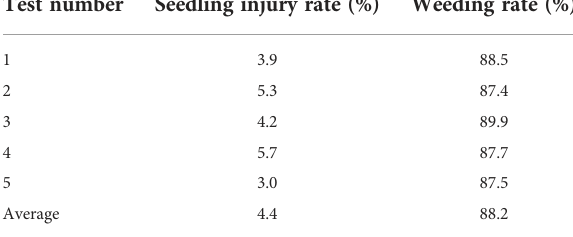
TABLE 5 Field experiment